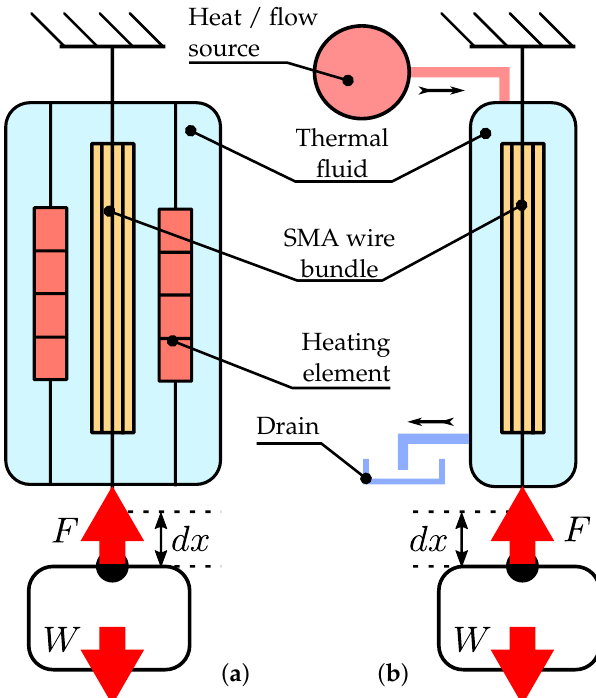
Figure 3. Novel concept abstraction for: ( a ) internal heat source, ( b ) external heat